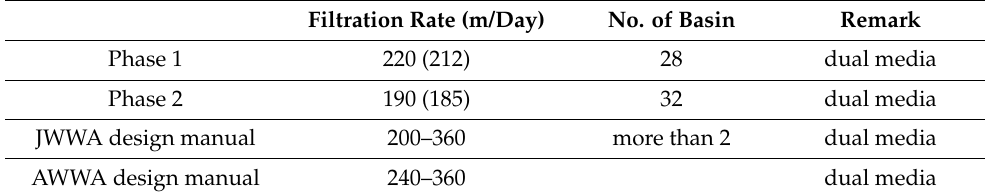
Table 2. Filtration rate in N-WTP and design